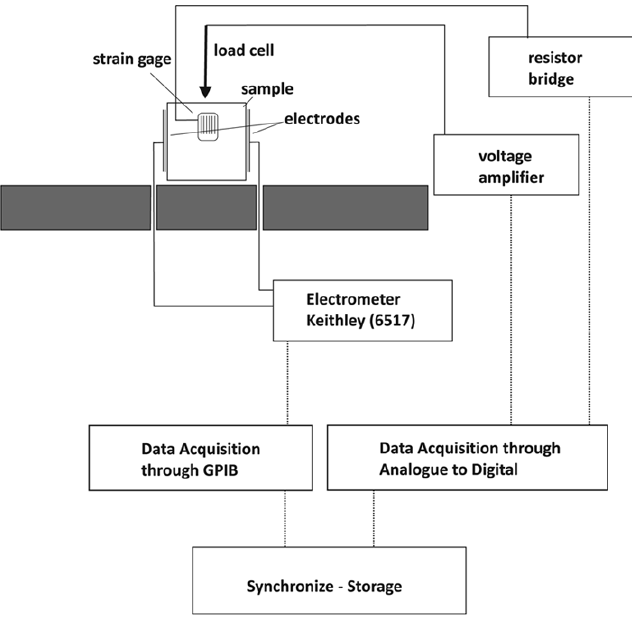
Figure 1. The experimental apparatus, as installed to capture the PSCs emitted during the application of the mechanical stress.